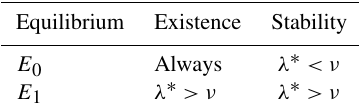
Table 3. Condition of the existence and stability of the equilibrium points of the model (Eq. 5).